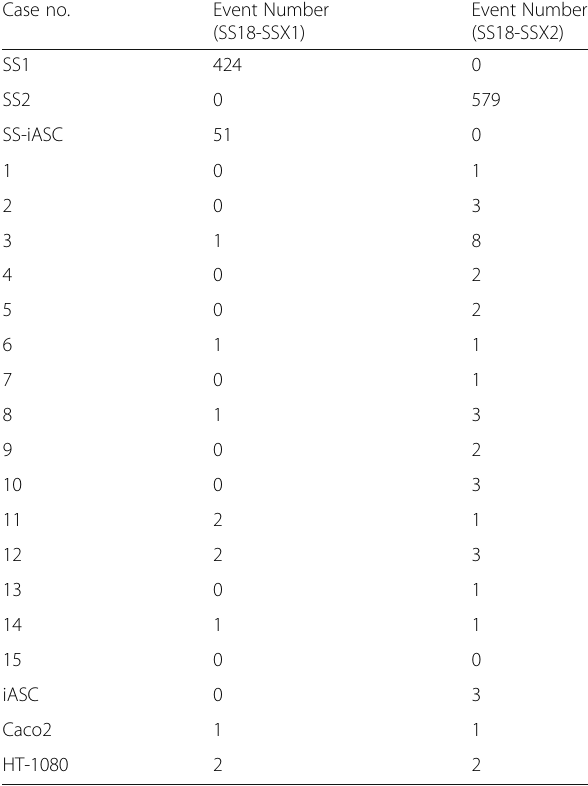
Table 2 Results of the ddPCR Case